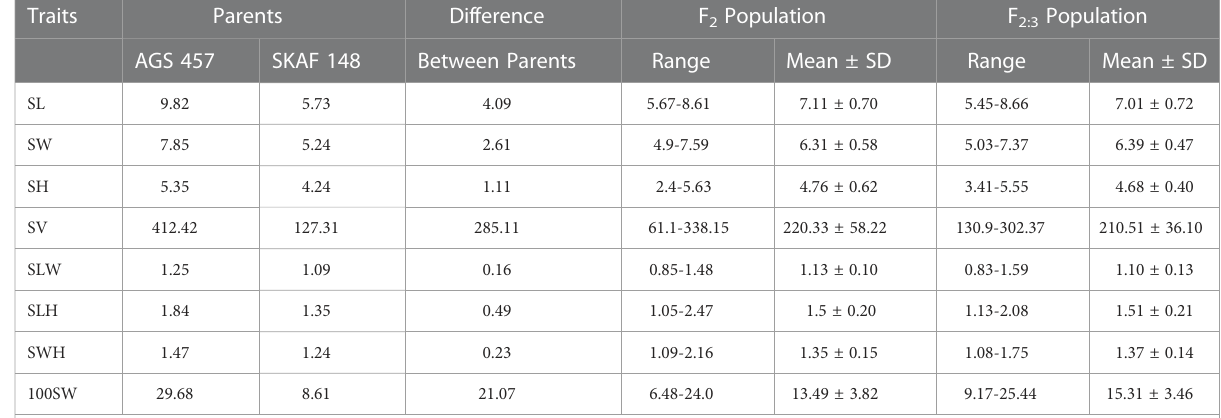
TABLE 1 Descriptive statistics of evaluated quantitative traits in parents, F 2 population and F 2:3 population.